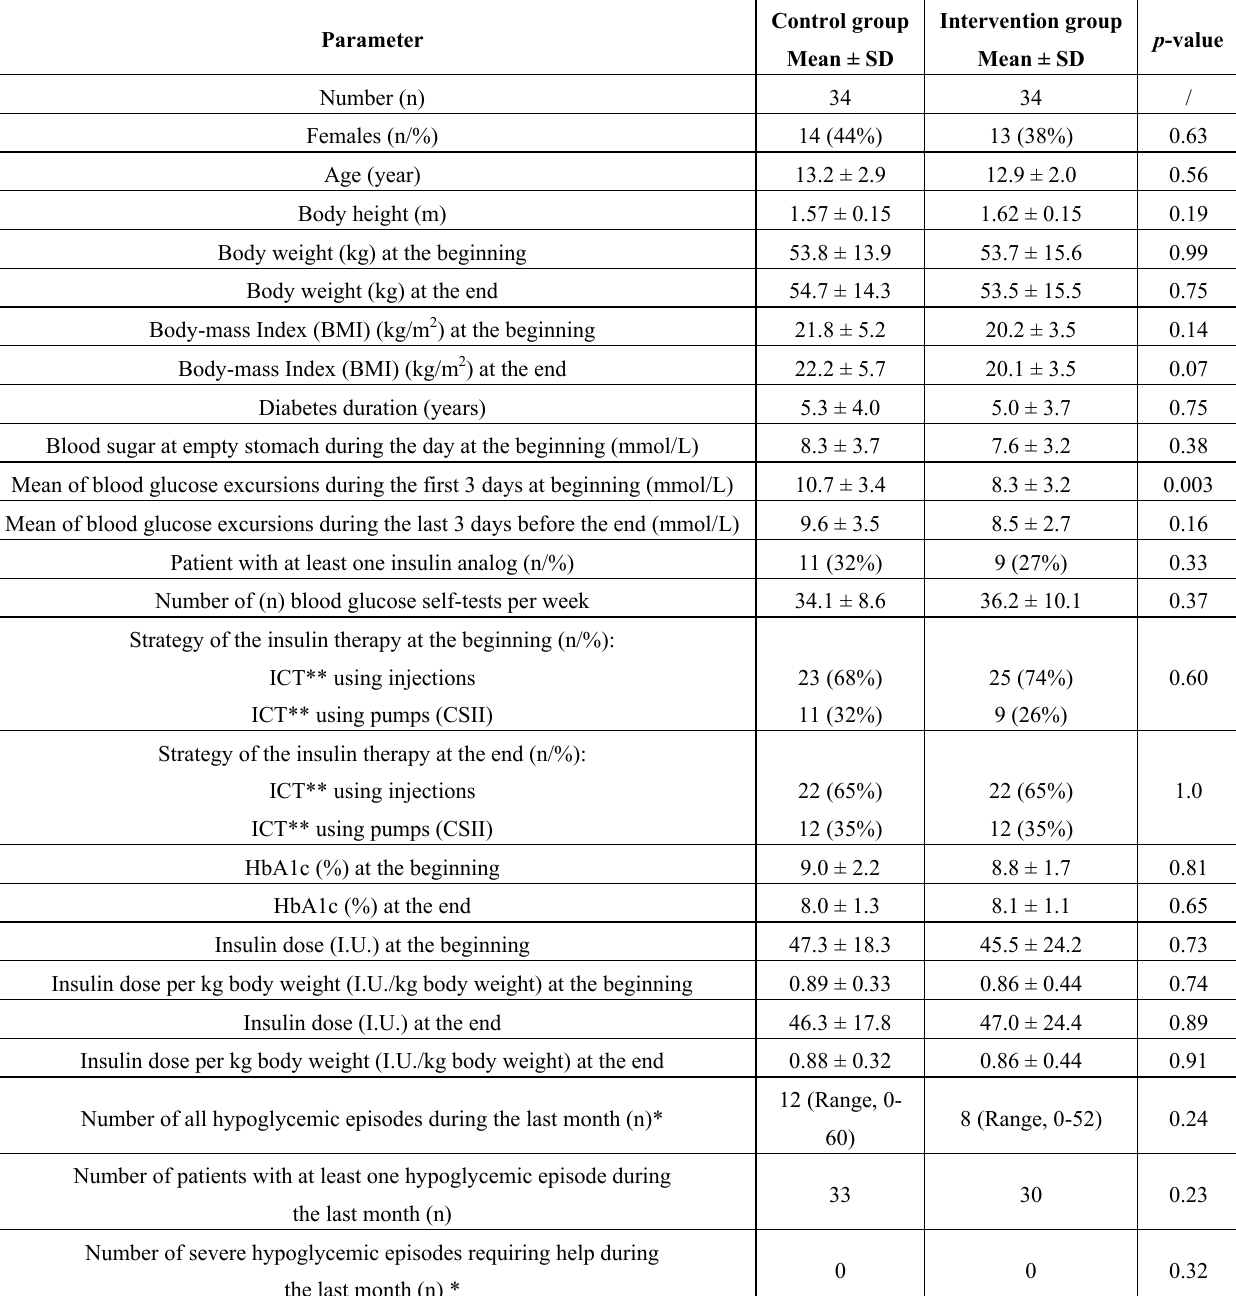
Table 1. Comparison between control and intervention